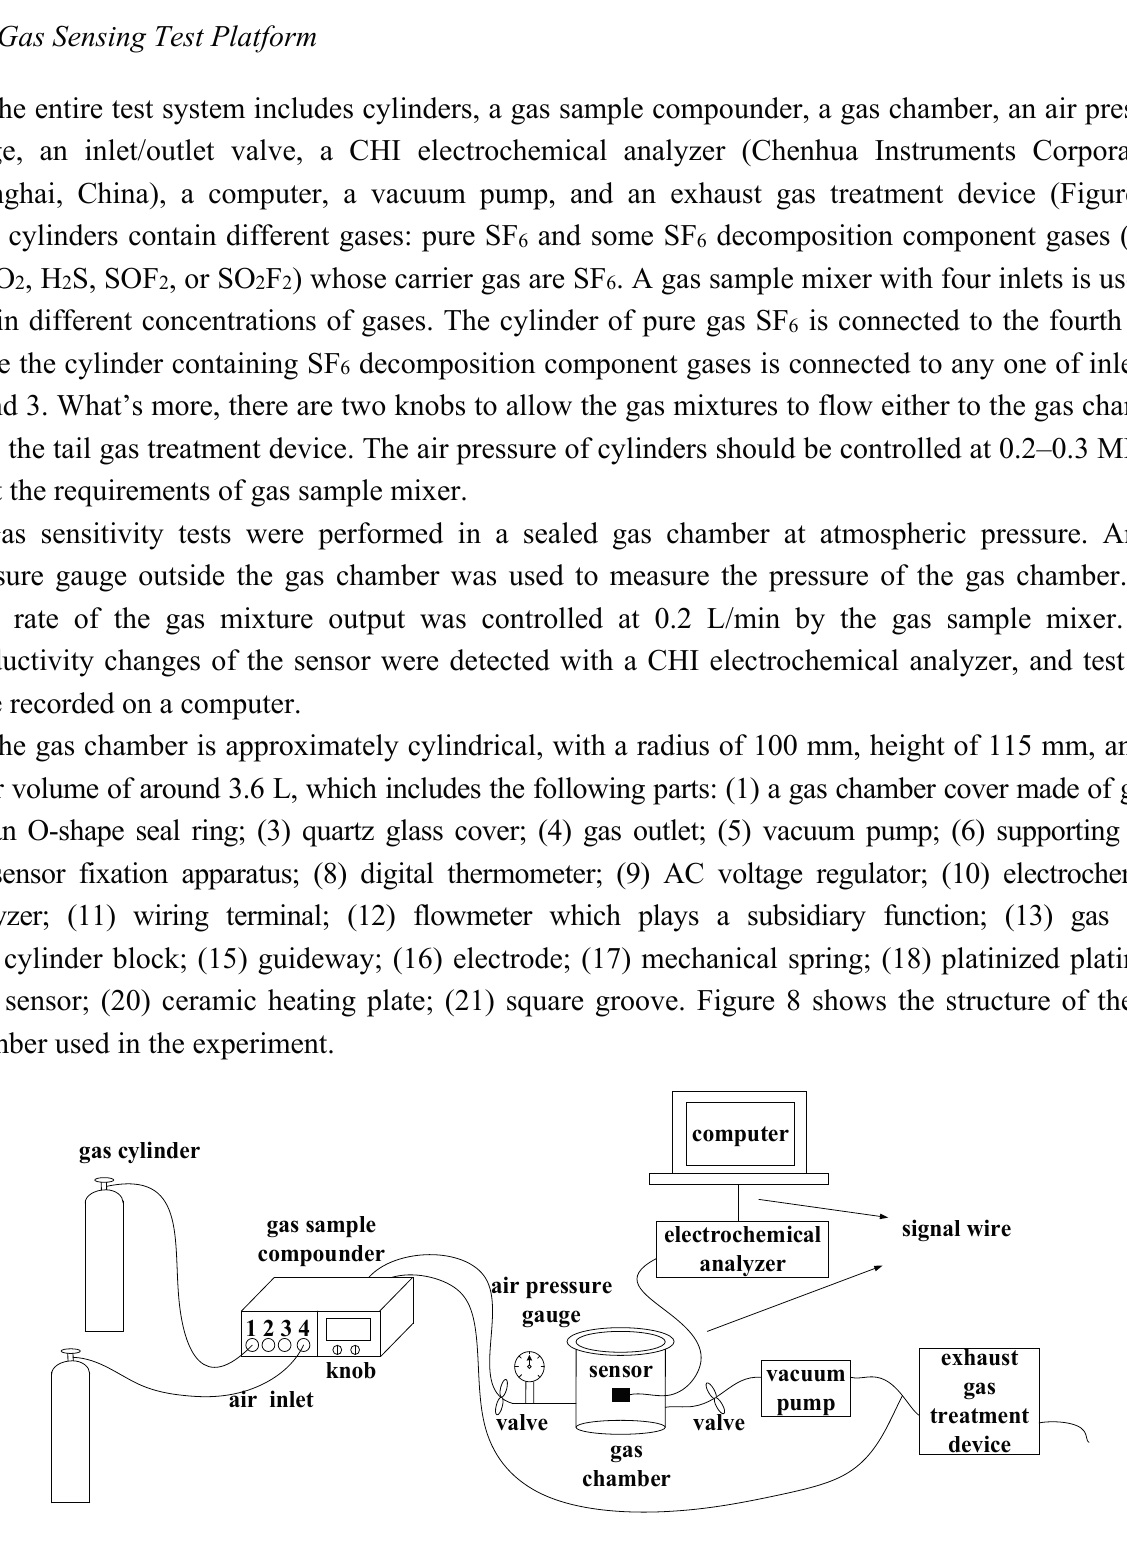
Figure 7. Schematic of the experimental and testing